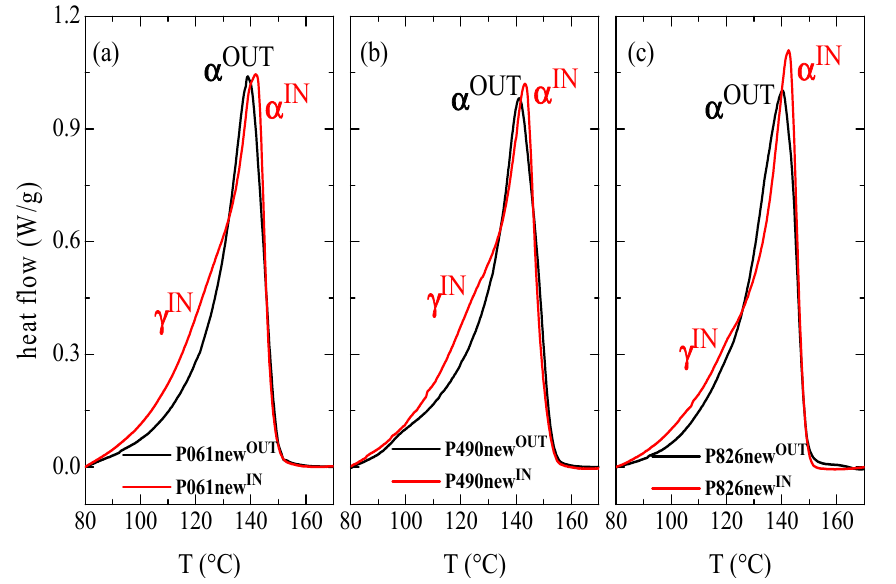
Figure 2. First DSC melting curves of the inner and the outer parts in the different new pipes: ( a ) P061; ( b ) P490; and ( c ) P826. ( b ) P490; and ( c )